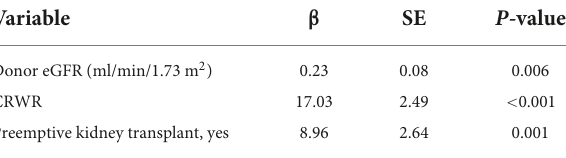
TABLE 2 Multiple regression analysis related to recipient‘s eGFR (ml/min/1.73 m 2 ) at 1